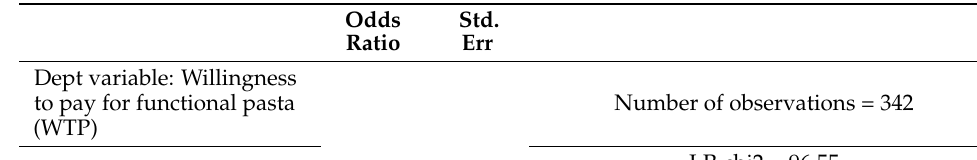
Table 5. Odds ratio of the ordered logistic regression model.